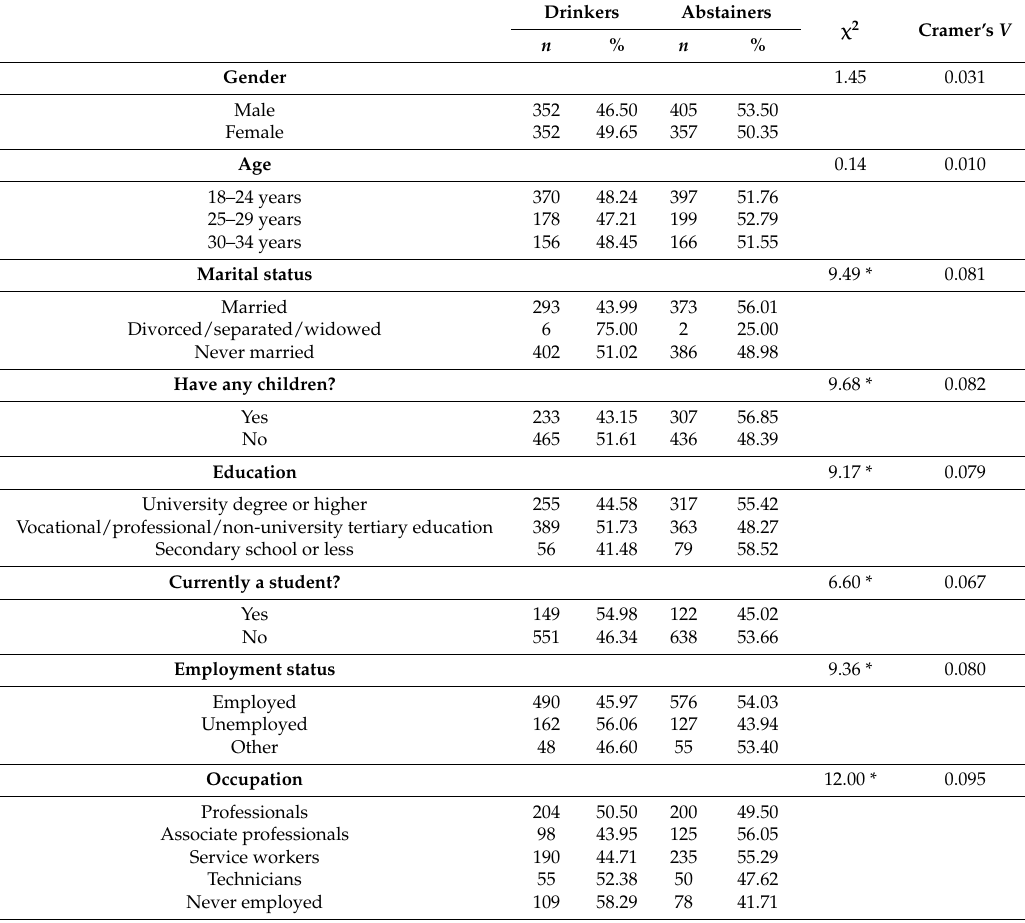
Table 1. Demographic comparison of Drinkers and